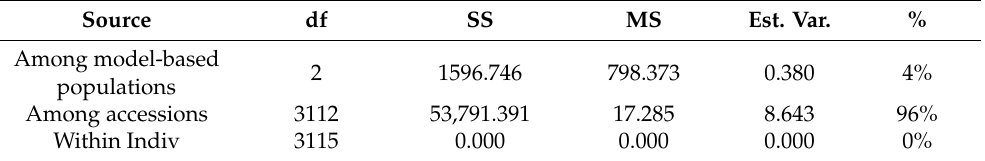
Table 5. AMOVA statistics of 10% core safflower accessions from model-based (43 varieties) populations. Source df SS MS Est. Var. Among model-based populations